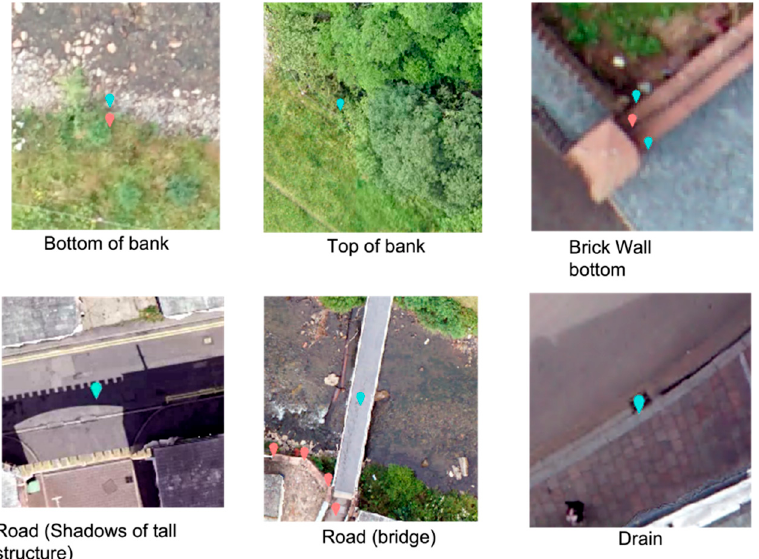
Figure 10. Examples of features where outliers are identified for both S1 and S2. Blue markers indicate outliers. Pink markers are points which fell within the interquartile